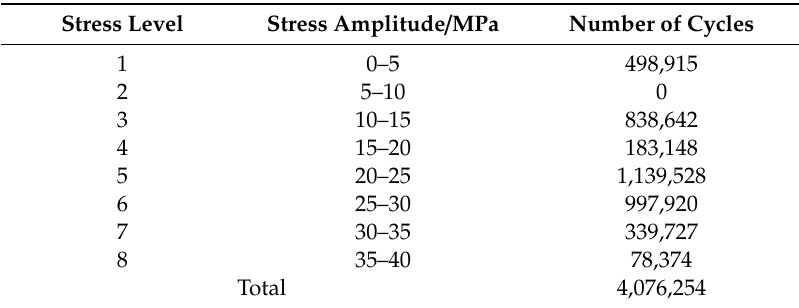
Table 11. Stress amplitude and the corresponding number of cycles (one year).